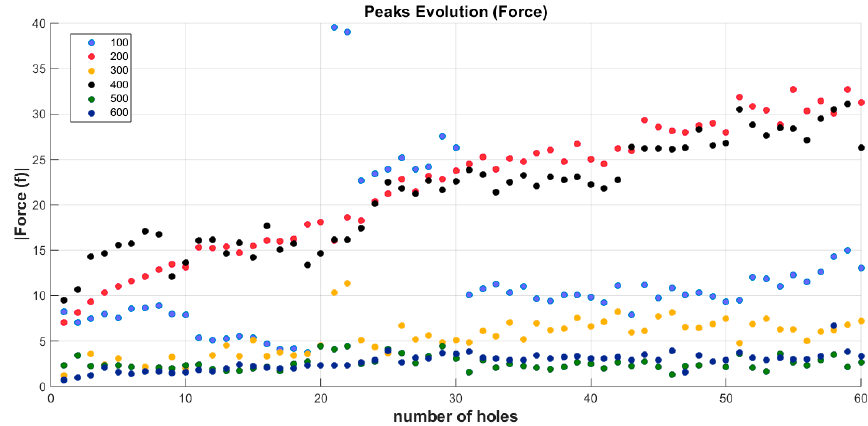
Figure 15. Frequency peaks of the thrust force vs. hole number (6000 rpm–0.15 mm/rev) [27].